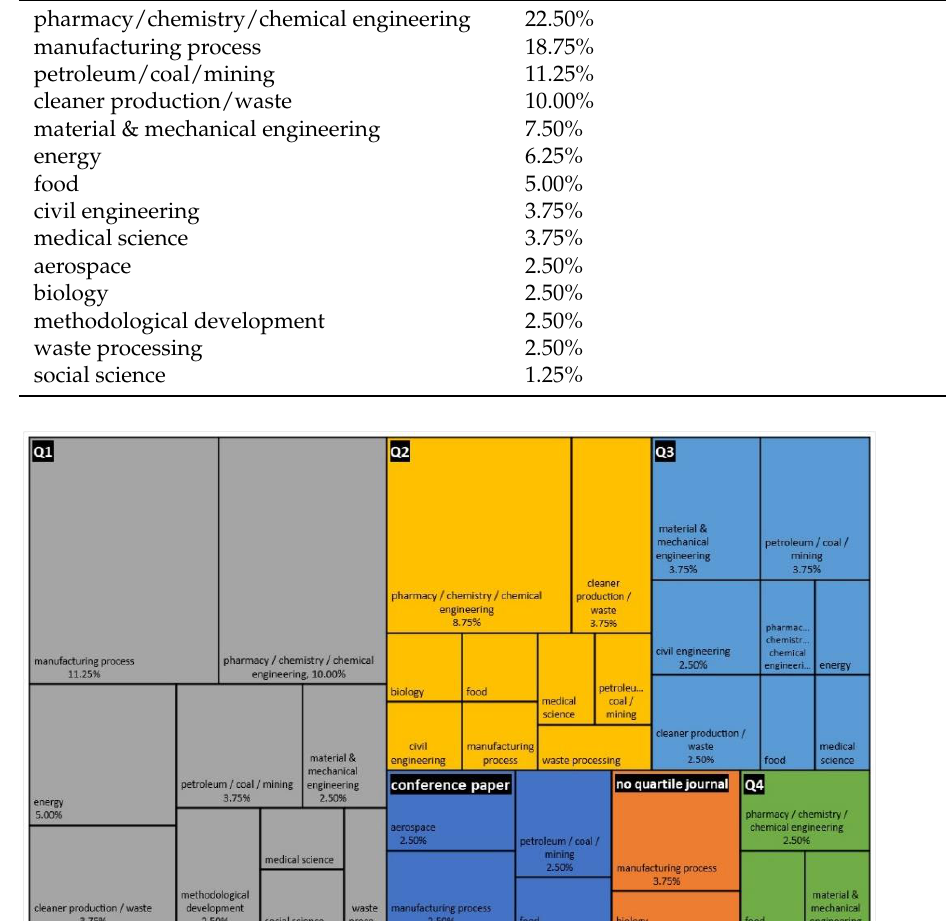
Figure 6. Journal quartile by research